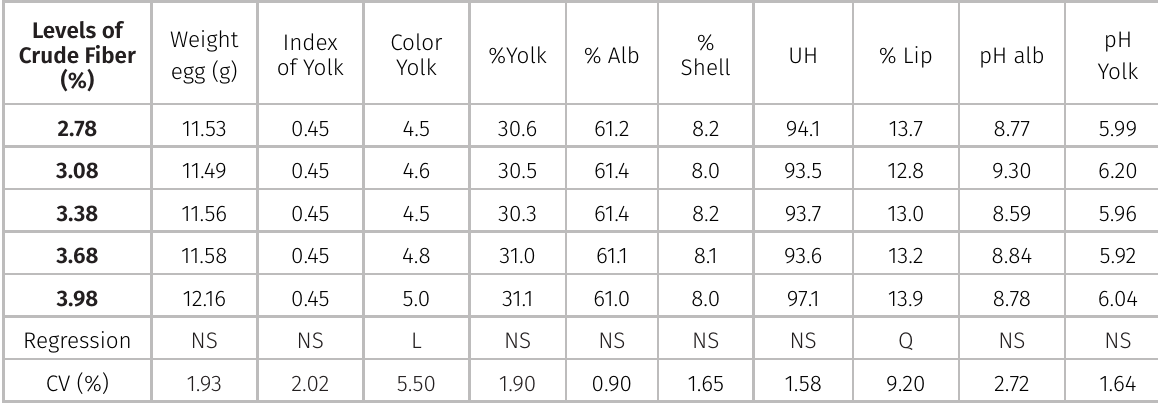
Table III. Egg weight (g), yolk index, yolk color, percentage of yolk (% yolk), percentage of albumen (% alb), percentage of shell (% shell), Haugh unit (UH), percentage of lipid in the egg (% Lip), pH of albumen (pH alb) and pH of yolk of Japanese quail eggs fed diets containing different levels of crude